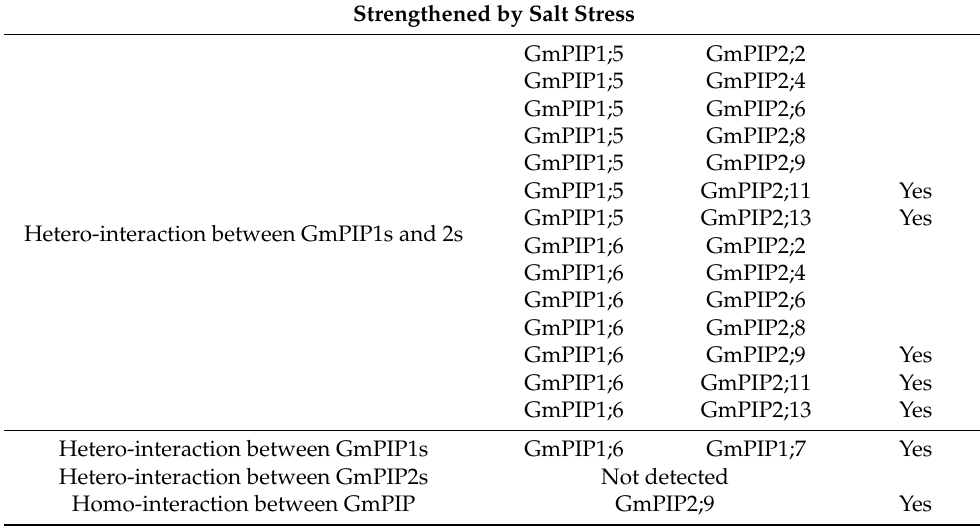
Table 1. The interactions that could be strengthened by salt stress are marked as well. Table 1. The strong interactions of Gm PIPs detected by